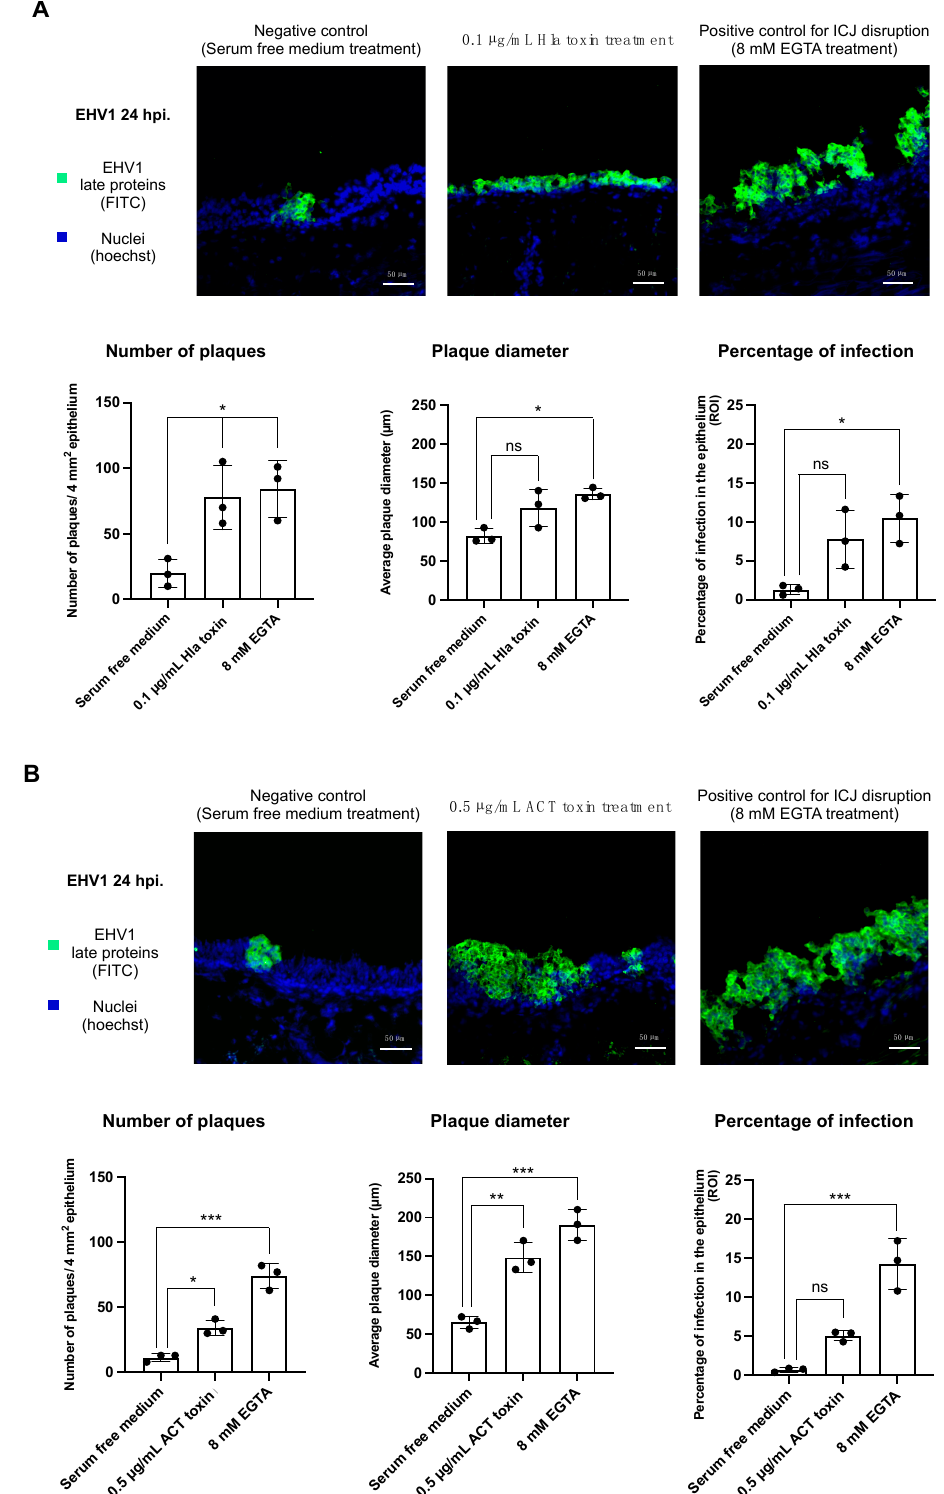
Figure 2. The effect of Hla and ACT toxin treatment on subsequent EHV-1 replication in the res- piratory epithelium at 24 hpi. EHV-1 infection in the epithelium was evaluated by performing an immunofluorescent staining against EHV-1 late proteins on 50 consecutive cryosections/explants. The infection was evaluated by determining (1) the number of plaques/4 mm 2 epithelium, (2) the average plaque diameter, and (3) the percentage of infection in the epithelium. ( A ) Effect of the